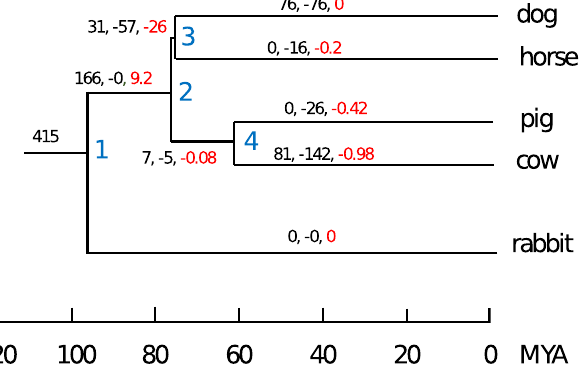
Figure 8. Gain and loss of miRNA seed sequences across the phylogeny. The tree labelling is equivalent to Fig. 2.